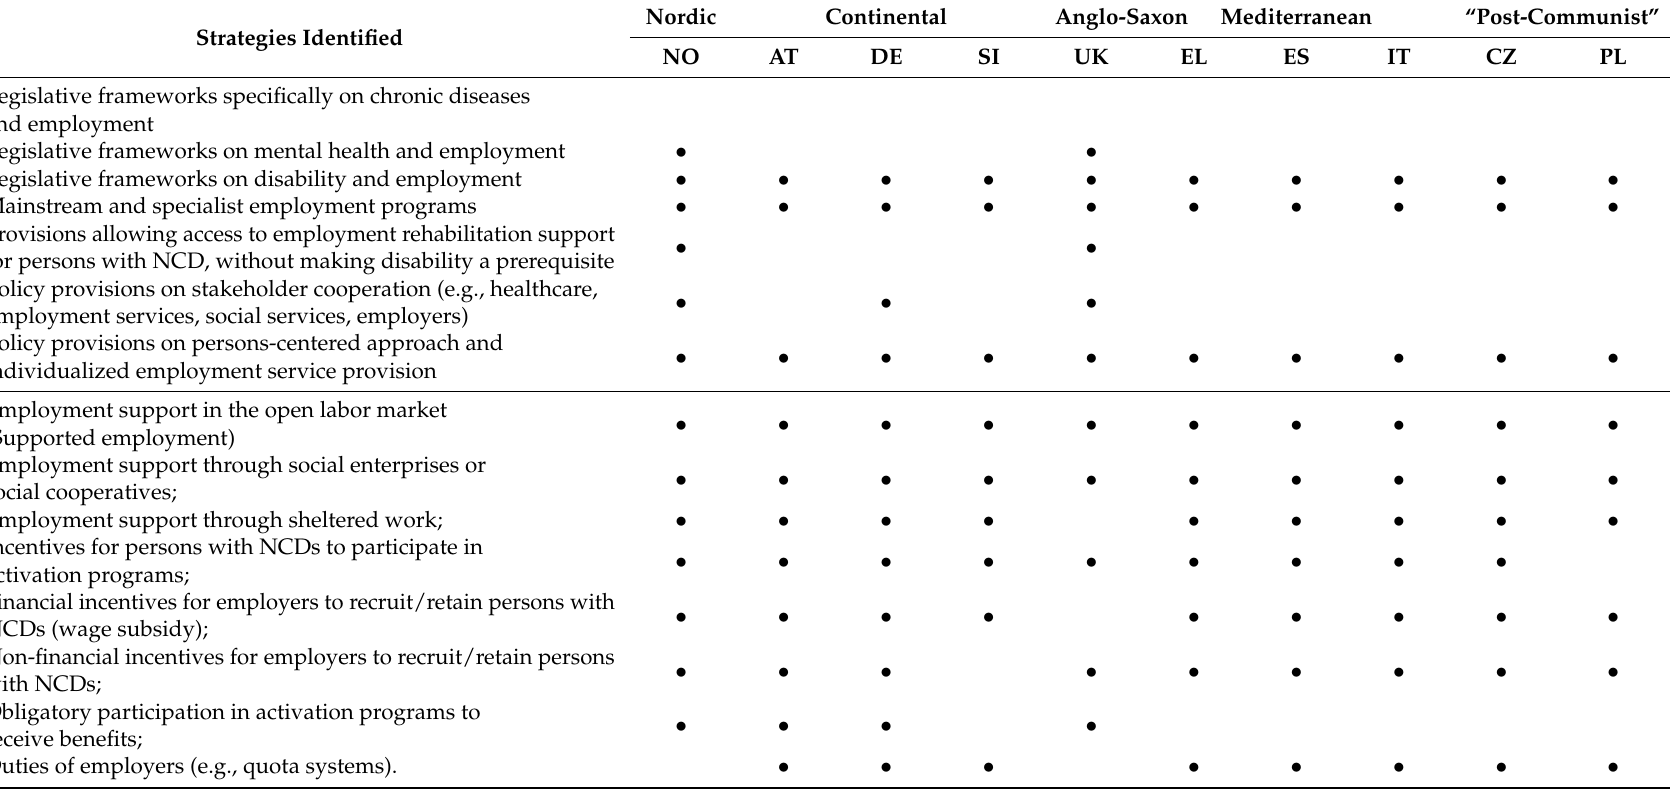
Table 3. National level strategies: Policies and